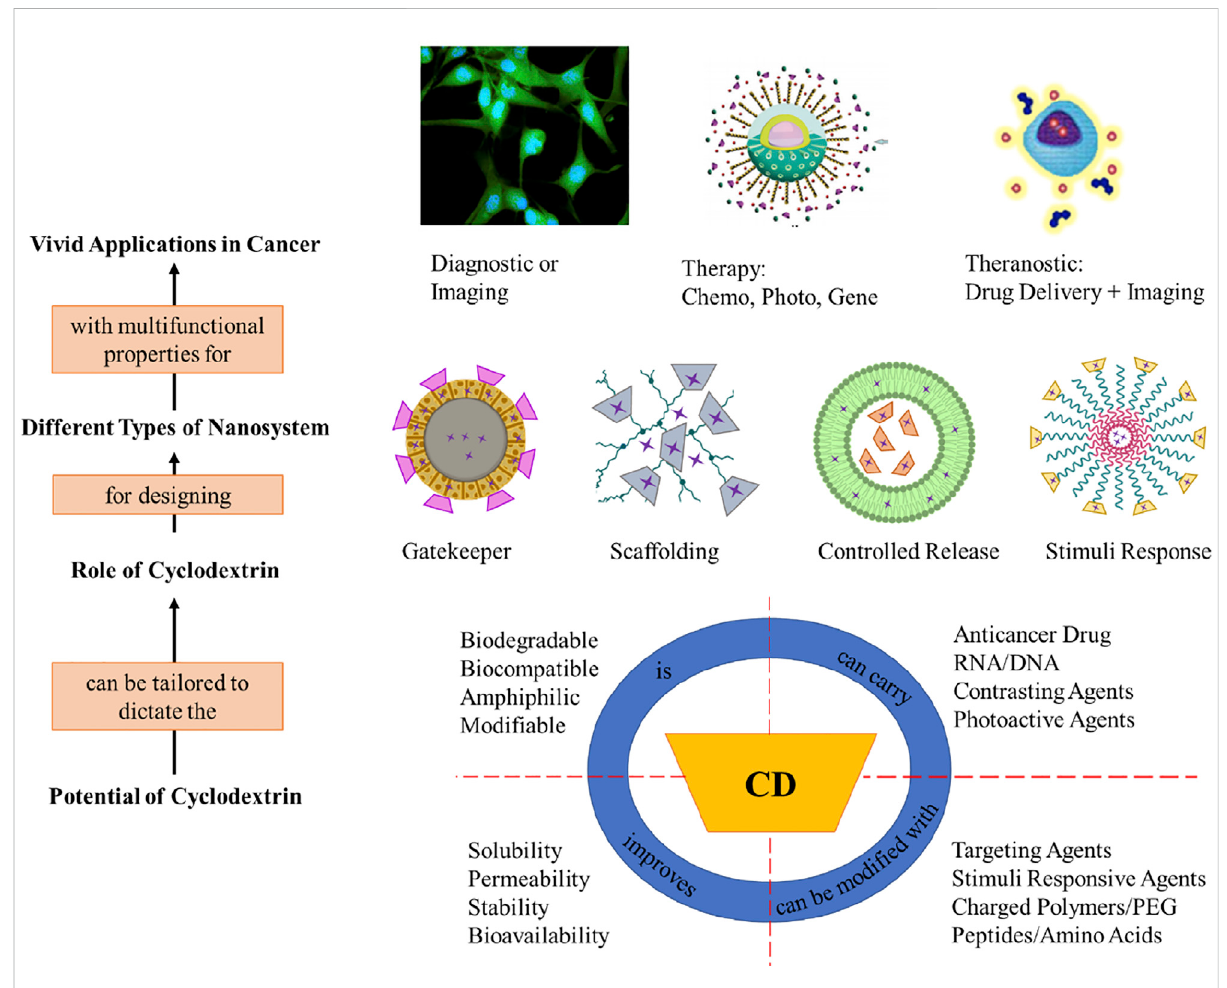
FIGURE 2 Summary of advantageous properties of cyclodextrin and their